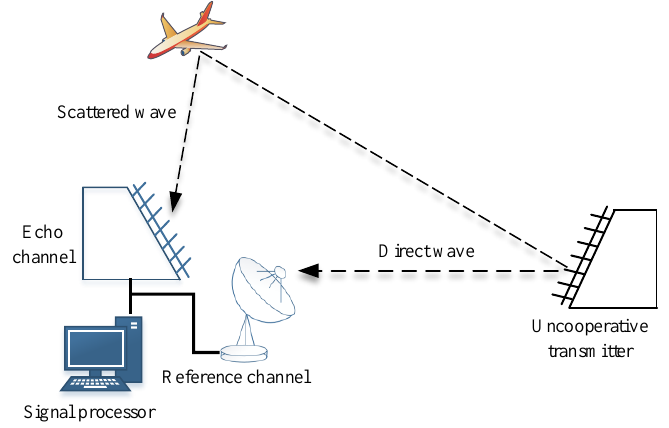
Figure 1. Geometry of PBR utilizing uncooperative radar signal as transmitter.